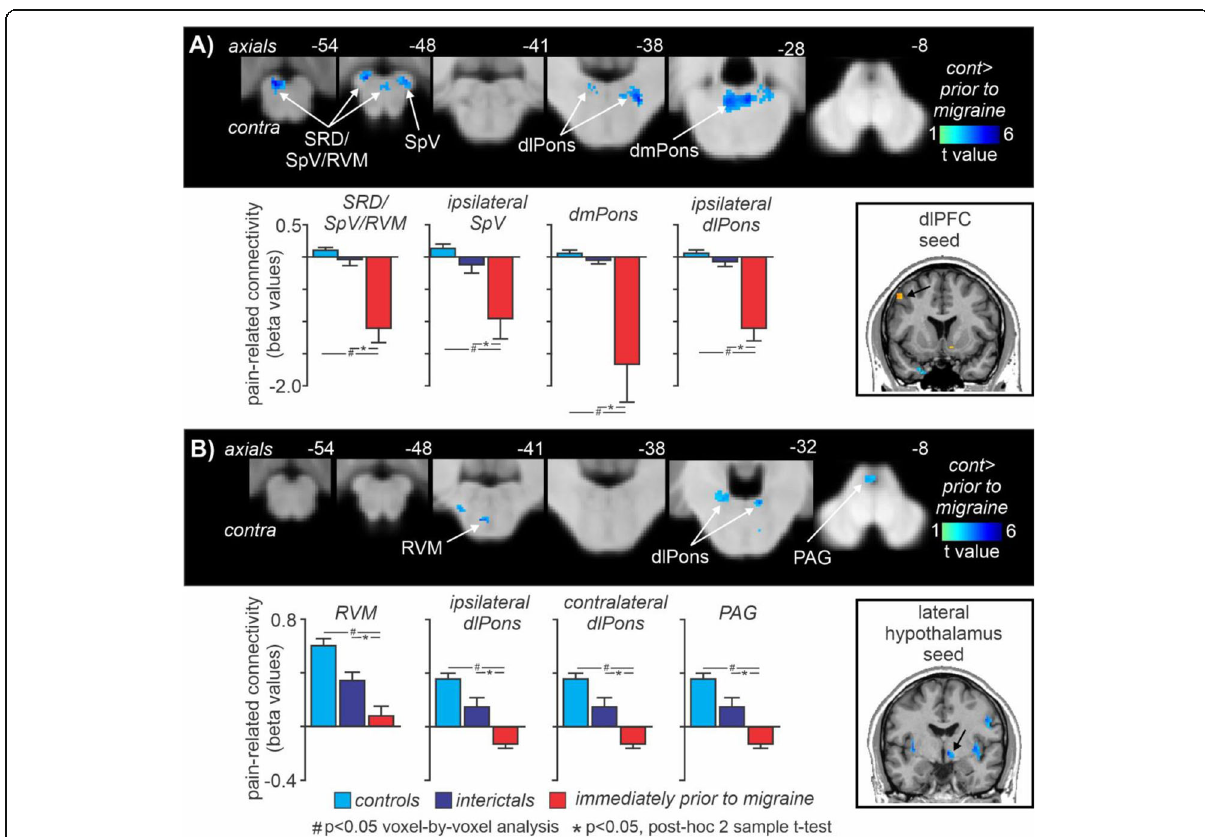
Fig. 5 Pain-related connectivity: Significant differences in ( A) contralateral dorsolateral prefrontal cortex (dlPFC) and ( B) ipsilateral hypothalamus acute pain-evoked changes in connectivity (psychophysiological interaction analysis) between controls and migraineurs in the period immediately prior to a migraine headache. Significant clusters are overlaid onto a mean T1-weighted brainstem template image. Slice locations in Montreal Neurological Institute space are indicated to the top right of each slice. The dlPFC and hypothalamic seeds are shown in the lower right inset. Note that dlPFC pain-related connectivity strengths were significantly reduced in a number of brainstem regions including the dorsomedial pons (dmPons), dorsolateral pons (dlPons), spinal trigeminal nucleus (SpV), and a cluster encompassing the nucleus reticularis dorsalis (SRD)/SpV and rostral ventromedial medulla (RVM). More restricted pain-related hypothalamic connectivity changes occurred in the dlPons, RVM and also in the region of the midbrain periaqueductal gray matter (PAG). Plots of mean (±SEM) beta values (effect sizes) revealed that pain-related changes in connectivity decreased significantly in migraineurs only during the 24-h period immediately prior to migraine, that is they were not different between controls and migraineurs during the interictal